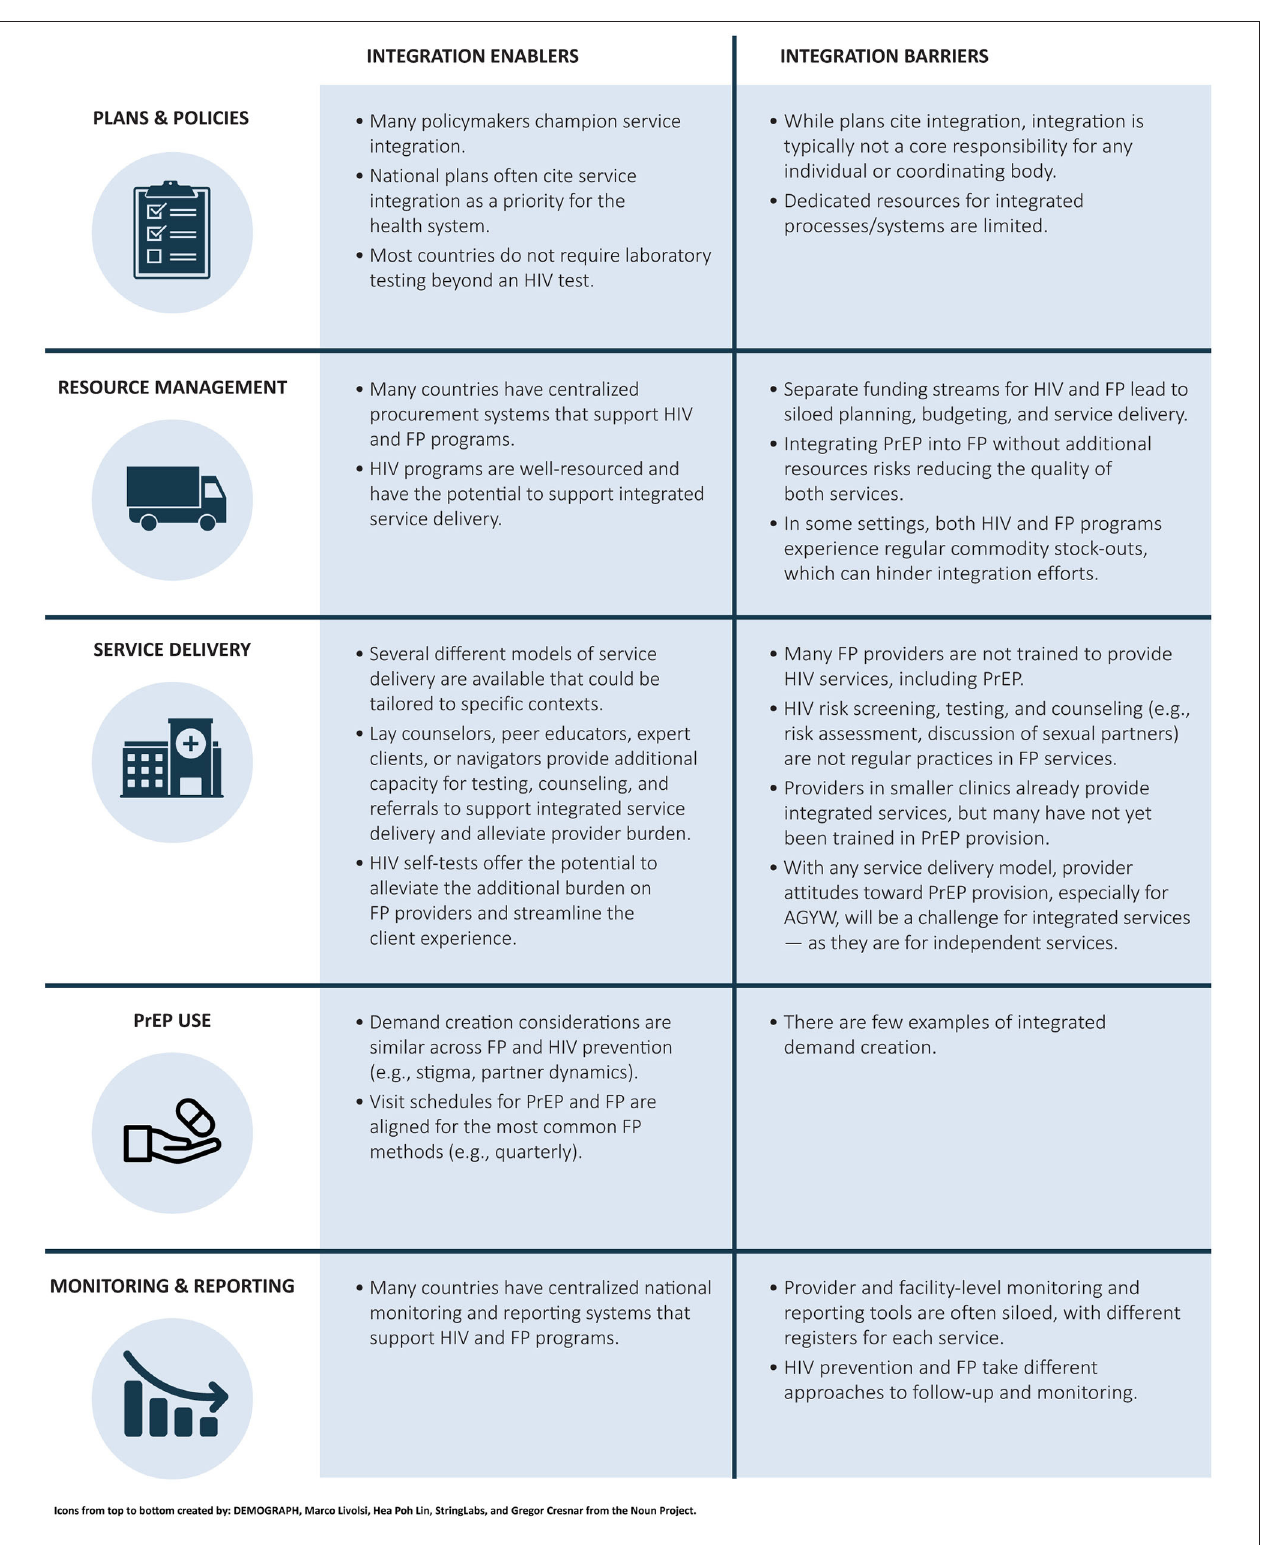
FIGURE 2 | Summary of key findings: consistent patterns across seven countries. FP, family planning; PrEP, pre-exposure prophylaxis; AGYW, adolescent girls and young women.